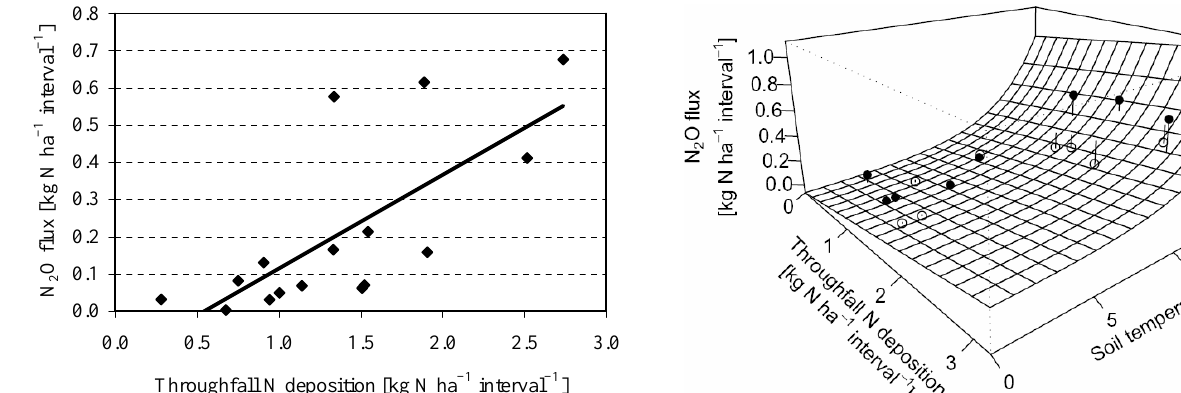
Fig. 4. Relationship of N 2 O fluxes ( y ) to throughfall N depositions ( x 1) and soil temperatures in 5cm soil depth ( x 2) ( y = 0 . 086 ( ± 0.063) · x 1 + 0 . 001 ( ± 0.000) · exp(0.468 ( ± 0.242) · x 2) − 0.042 ( ± 0.073); r 2 = 0 . 78, P < 0 . 0001, df = 13). The measured data are indicated as points, where black points are located above the surface area and white points are located below the surface area. The solid lines indicate the deviations of measured data from the model.